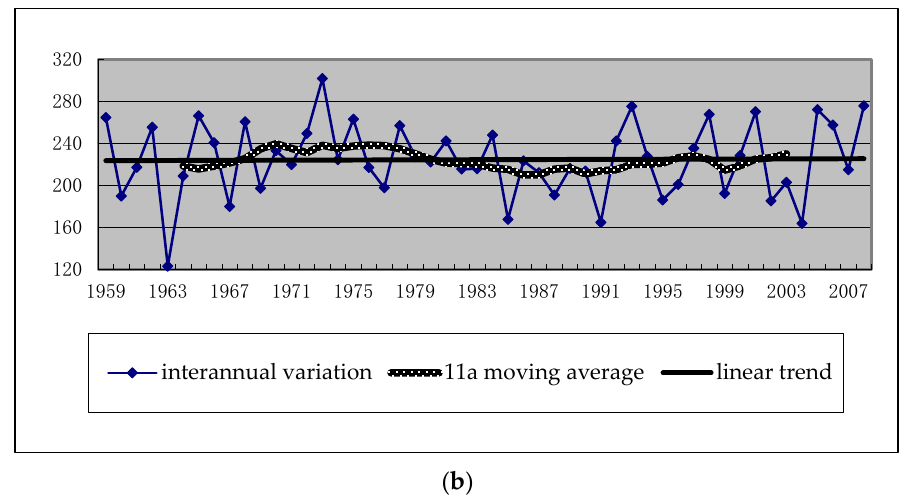
Figure 2. The mean rainfall in PFSSC ( a ), and the interannual variation curve of rainfall in PFSSC, 11a moving average curve and the trend line ( b , the time series of rainfall, unit: mm·mo −1 ).